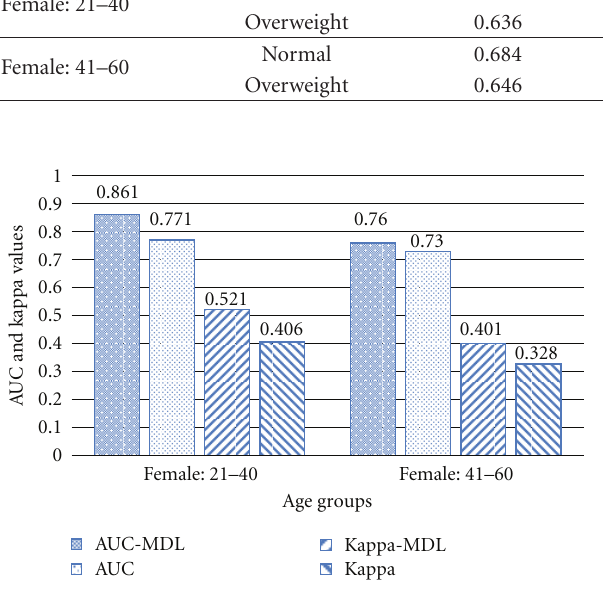
Figure 2: A comparison of performance evaluations using AUC and kappa in 2 female groups (AUC-MDL and Kappa-MDL: use of MDL, AUC and Kappa: without the use of